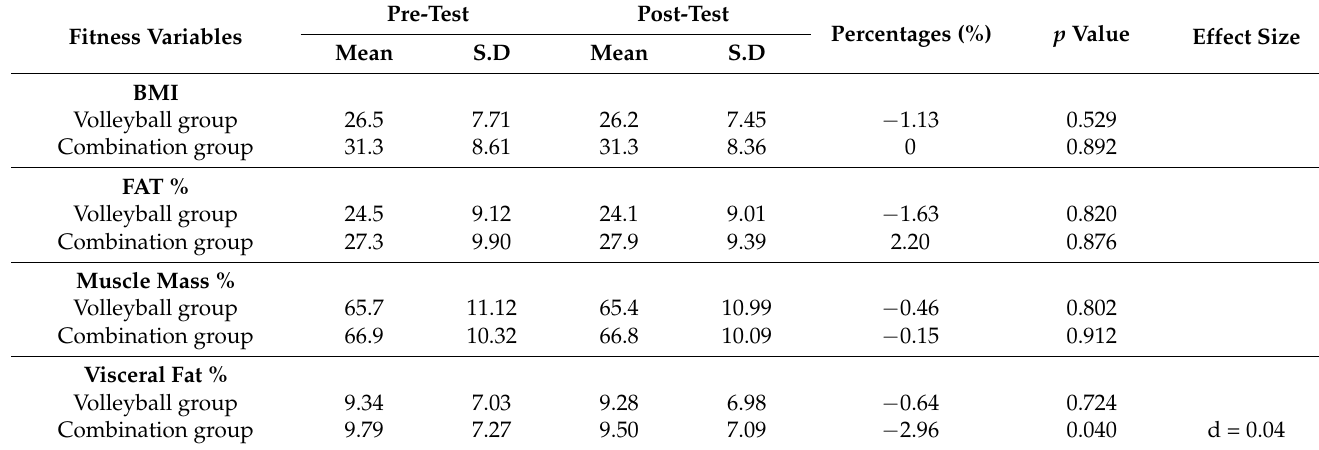
Table 3. Analysis of data for the selected anthropometric variables from Pre- to Post-test in Combination and Volleyball